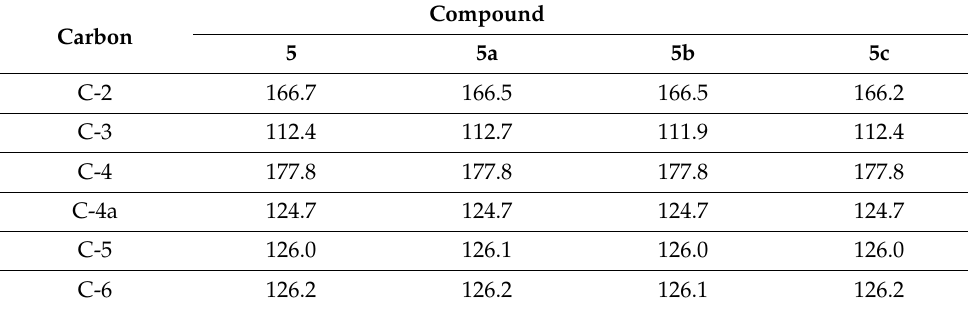
Table 4. 13 C-NMR chemical shifts δ (ppm) and coupling constants J (Hz) of 2 (cid:48) -methylflavone ( 5 ) and products of its biotransformations 5a – 5c in Acetone-d6, 151 MHz (Supplementary Materials: Figures S108, S123, S139,